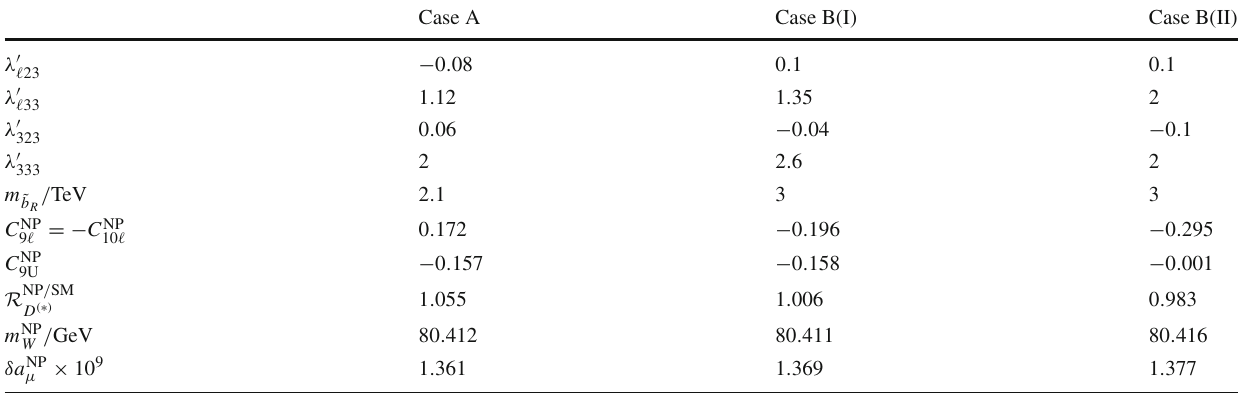
Table 3 The benchmark points in Case A ( (cid:4) = 1 and e ) and B ( (cid:4) = 2 and μ ). The Wilson coefficient C NP contribution (see Ref.